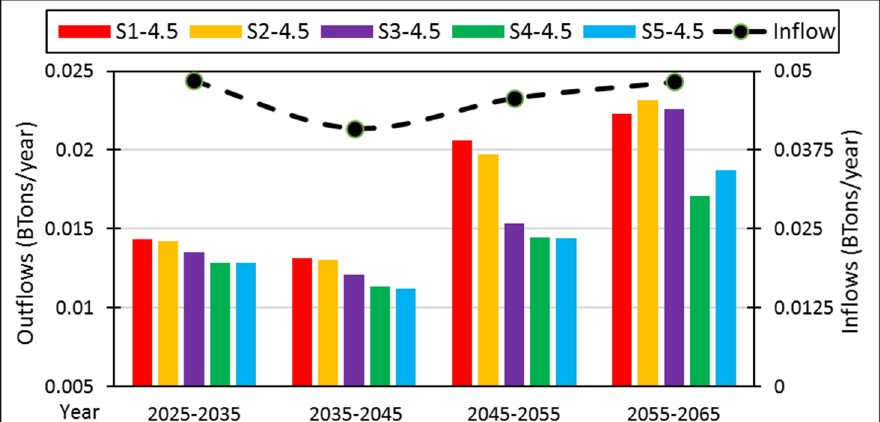
Figure 17. Total sediment inflows and outflows from the reservoir.